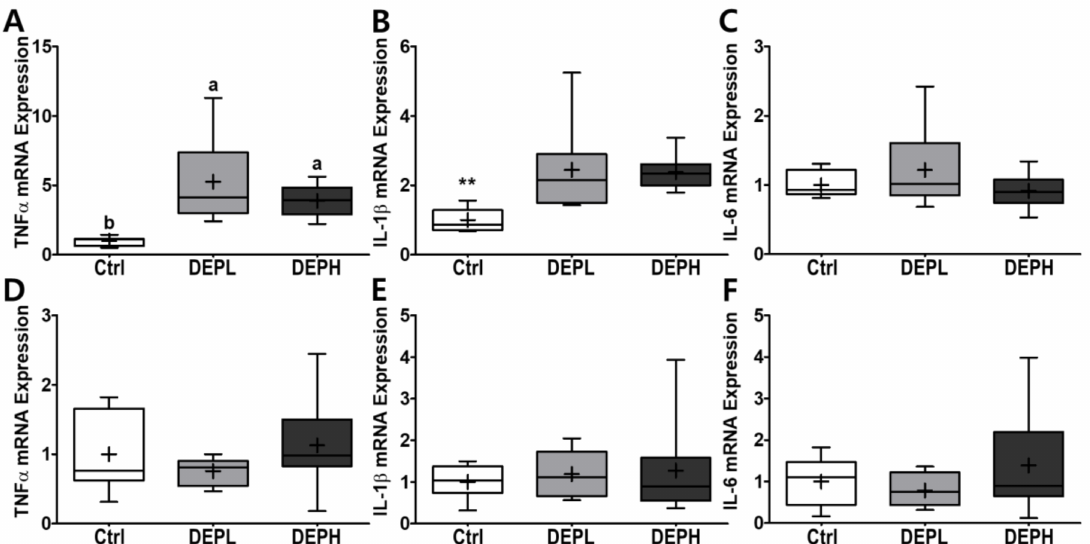
Figure 6. Box-and-whisker plots representing pulmonary and hepatic inflammatory cytokine mRNA expressions after diesel exhaust particles (DEP) exposure. Pulmonary ( A ) tumor necrosis factor-alpha (TNF α ), ( B ) interleukin 1 beta (IL-1 β ), and ( C ) IL-6, as well as hepatic ( D ) TNF α , ( E ) IL-1 β , and ( F ) IL-6, were analyzed through qRT-PCR by normalization of glyceraldehyde-3-phosphate dehydrogenase (GAPDH) mRNA expression; n = 8 for each group. A One-way ANOVA followed by Tukey’s post-hoc test was conducted; labeled means without a common letter differ ( p < 0.05); ** p <